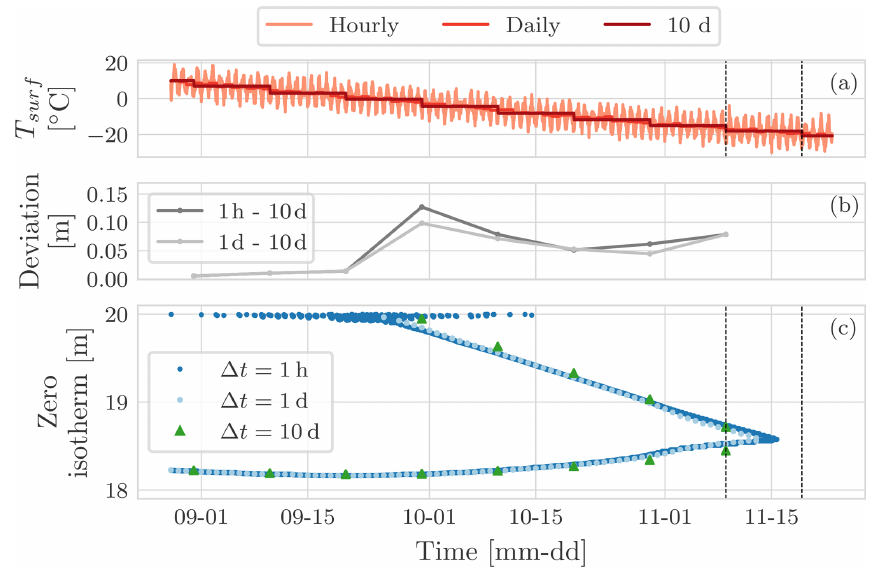
Figure G2. Detail of the beginning of the freezing season for the year 1999. Panel (a) shows the surface temperature for the hourly, the daily, and the 10d simulations. Panel (b) shows the deviation of the position of the zero isotherm after 100 years between the hourly and the 10d simulation, as well as between the daily and the 10d simulation. Panel (c) shows the position of the zero isotherm after 100 years for the three simulations. The joining of the downward and upward freezing front is captured by the hourly and the daily simulations (c) . It is interesting to note that for the 10d simulation the joining occurs in between two consecutive time